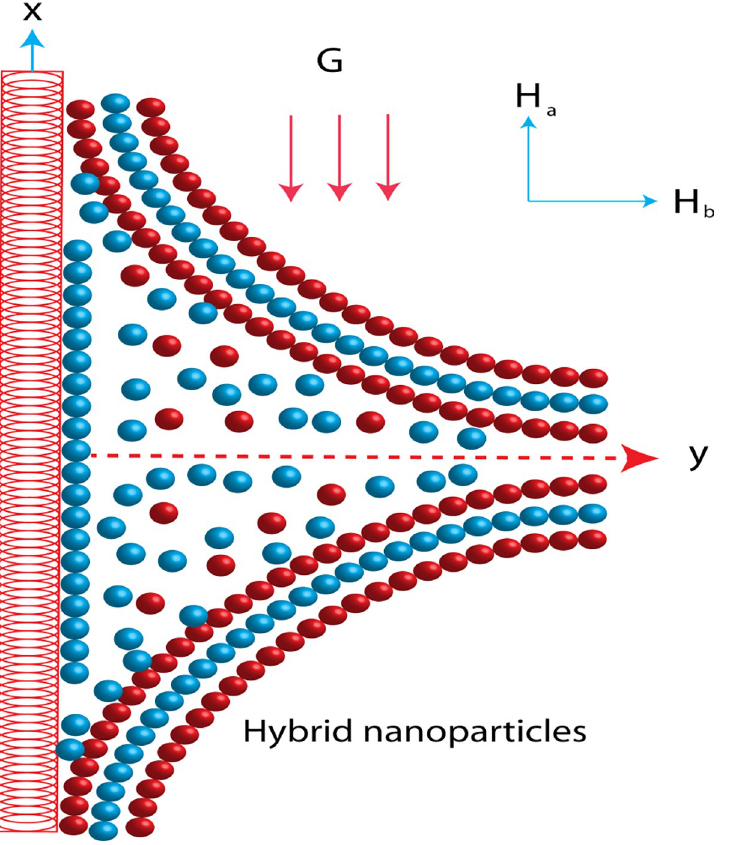
Fig 2. Geometrical view of flow